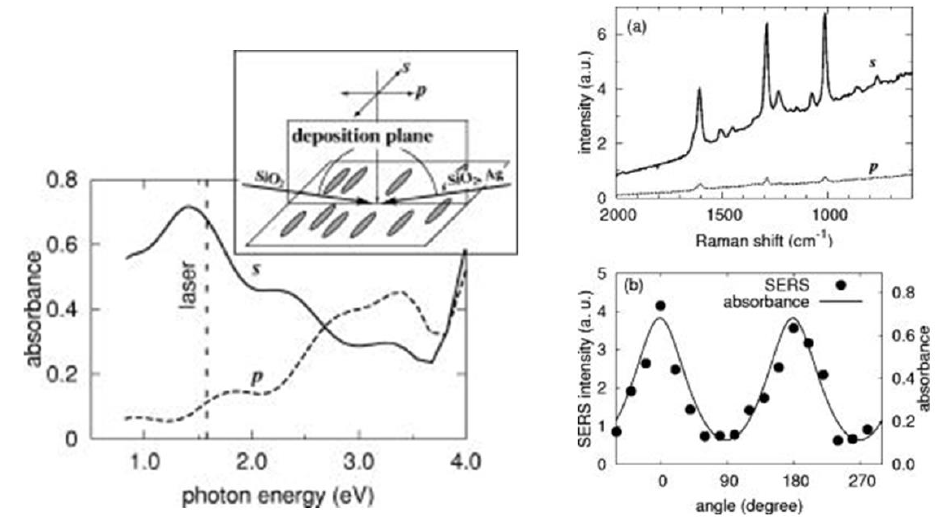
Figure 19. Left: The absorbance spectra of the Ag NR arrays tuned to the Raman spectroscopy at an excitation wavelength of 785 nm (1.58 eV). The incident light was either p or s polarized, where an electric field vibrates parallel or perpendicular to the deposition plane, respectively, as shown schematically in the upper right box. Right: Polarization dependence of the Raman spectra ( a ) and the peak intensity at 1014 cm −1 ( b ). The polarization dependence of the absorbance at the wavelength of 785 nm is also shown ( b ). Adapted with permission from [98].